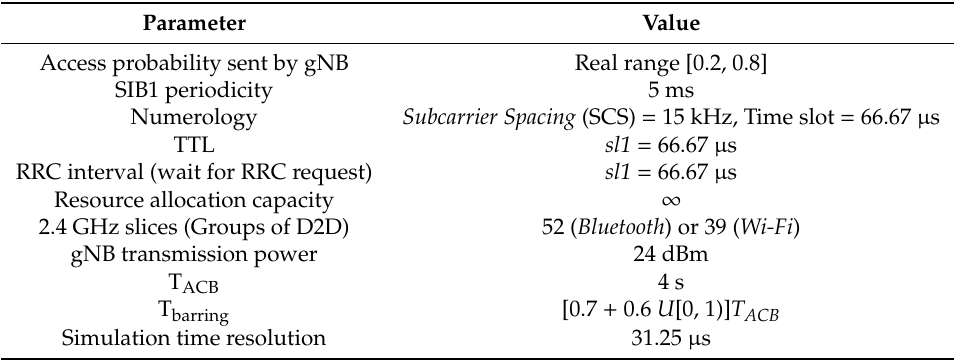
Table 2. Parameters used by the gNB in the simulation.